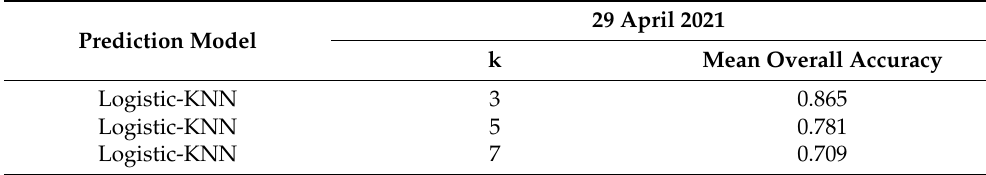
Table 3. The mean overall accuracy according to fivefold cross-validation for the 29 April 2021 model when the threshold of probability was